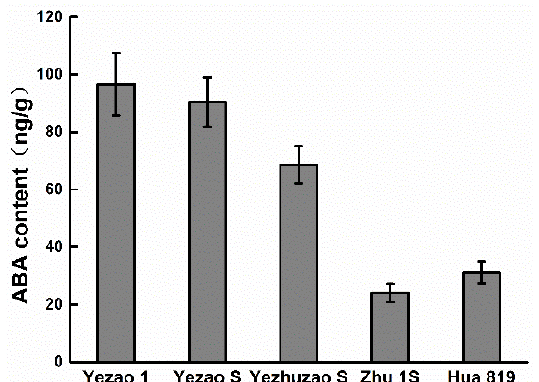
Figure 5. Comparison of the difference of abscisic acid (ABA) content in seeds.